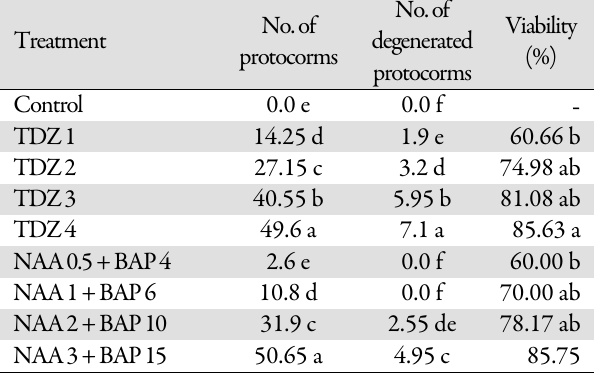
Table 2. The effects of growth regulators (TDZ, BAP and NAA) on the production and survival of protocorms obtained from leaf explants of P. amabilis var.